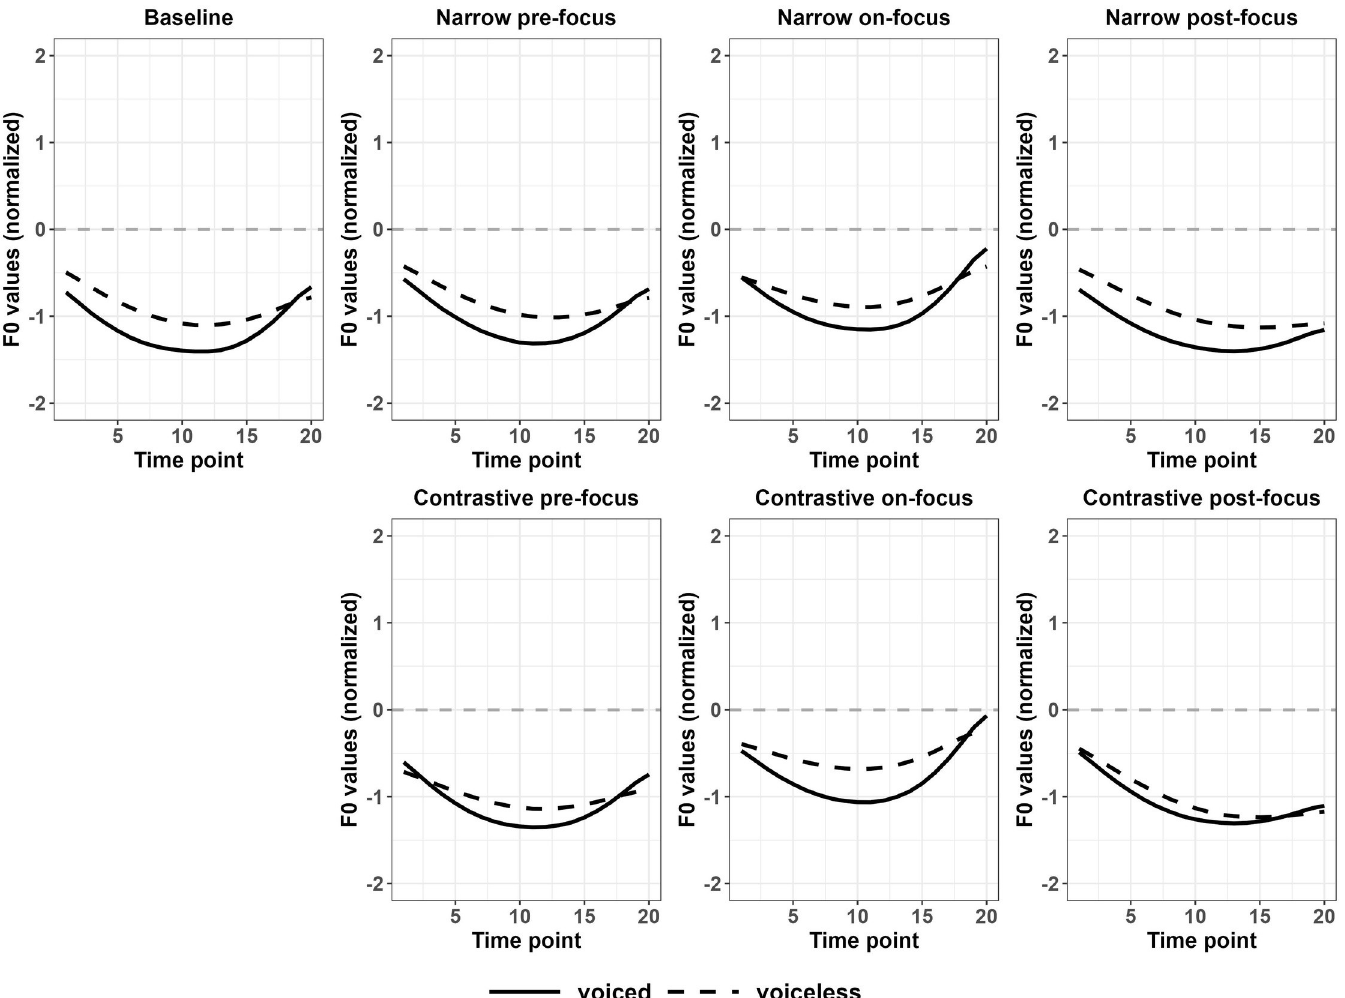
Fig 12. Normalized f0 contours of disyllabic LH targets between voiceless and voiced stops (Japanese).